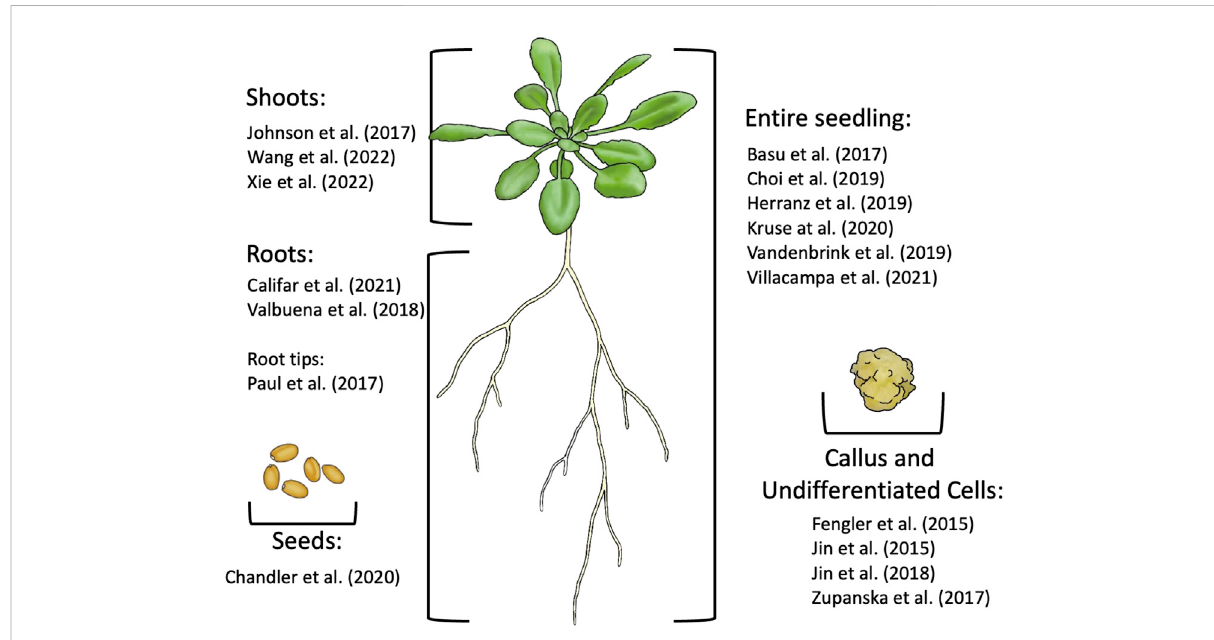
FIGURE 5 Summary of the tissue types used for -omic analysis from recent space fl ight experiments with